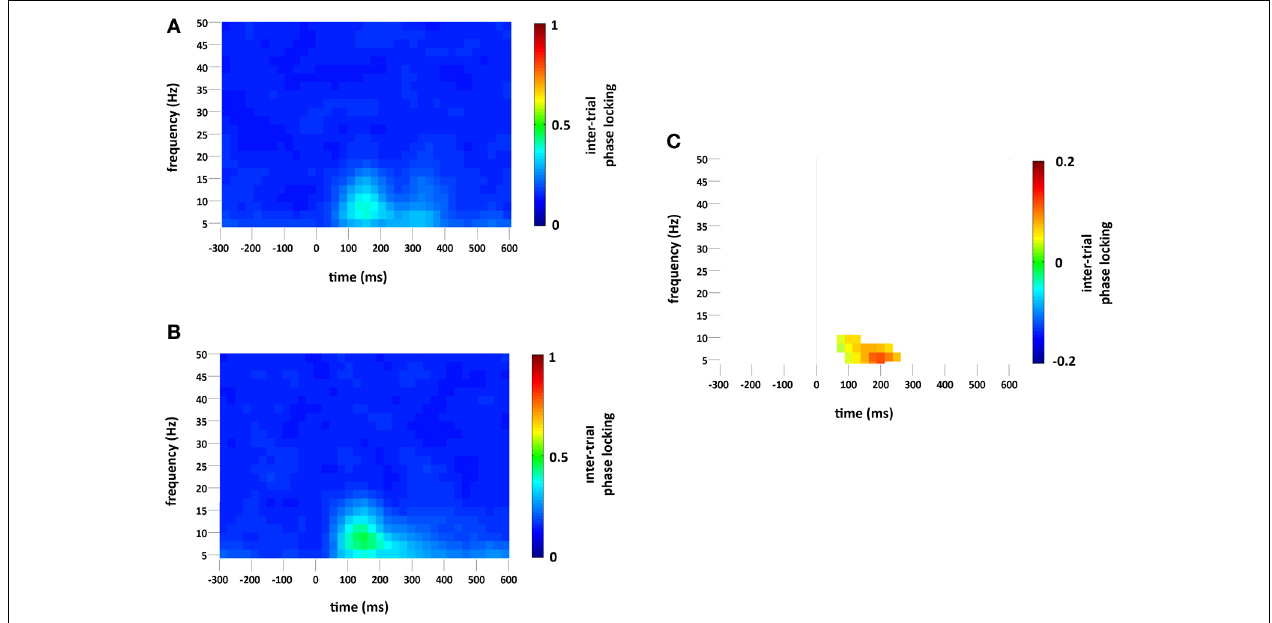
FIGURE 5 | ITPL (ranging from 0 to 1, with values approaching 1 indicating highly correlated phase values) at the occipital region of interest compared to baseline ( − 300 to 0ms) for (A) standard and (B)